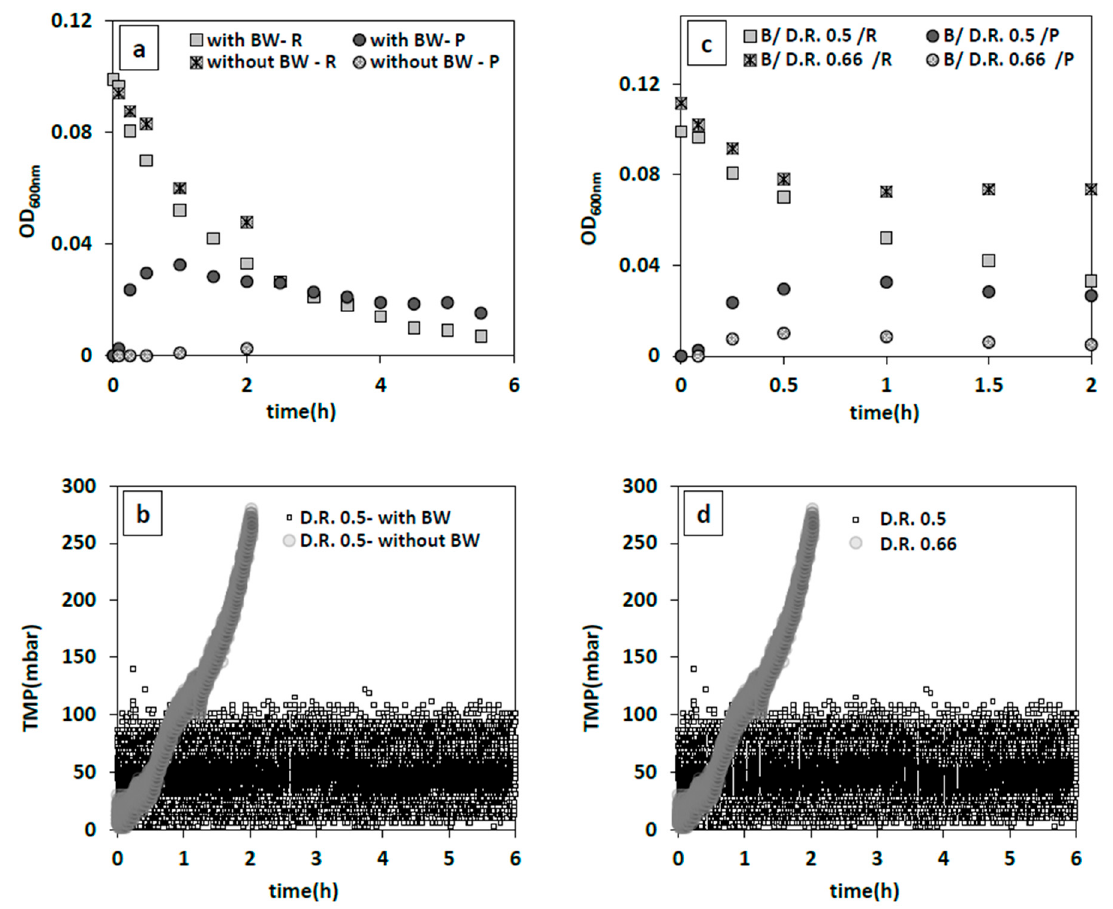
Figure 4. Changes in the ( a ) optical density of reactor media (R) and permeate line (P) and ( b ) TMP during the filtration of bacteria containing medium with and without backwash (BW). The comparison between the changes in the ( c ) turbidity and ( d ) TMP using different dilution rates (D.R.) for bacteria filtration.